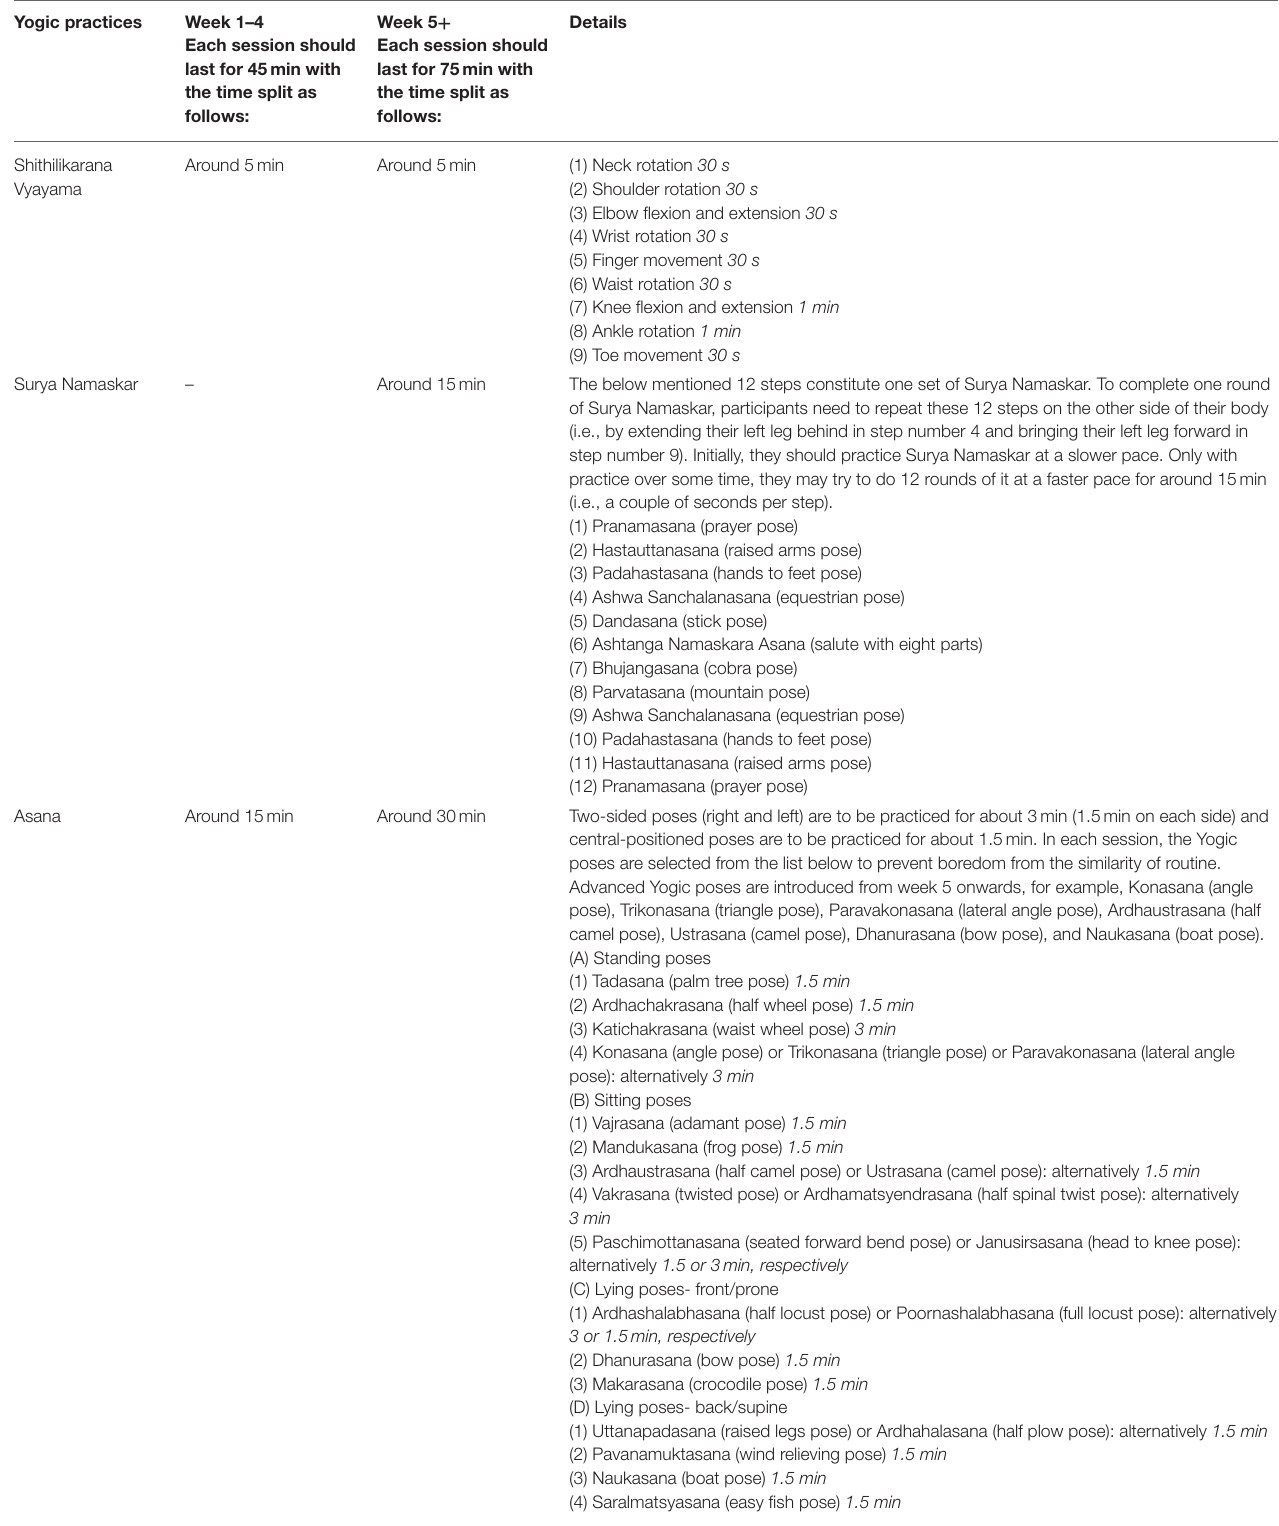
TABLE 4 | Structure and content of the Yoga sessions. Yogic